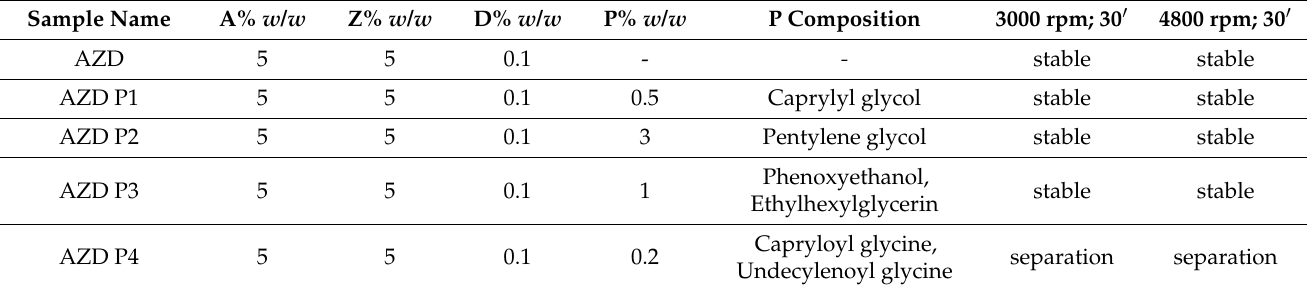
Table 7. Stability test results of emulsions formulated with Zea mays starch A and zinc oxide Z (total solid phase at 10% w / w ), diutan gum D at 0.1% w / w , oily phase at 10% w / w and different preservative molecules P.